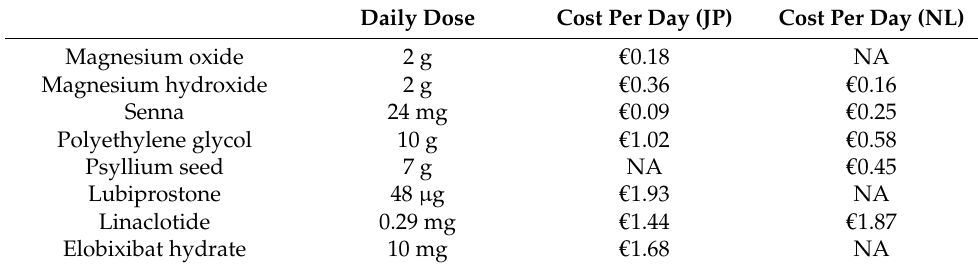
Table 1. Comparison of laxative drugs by